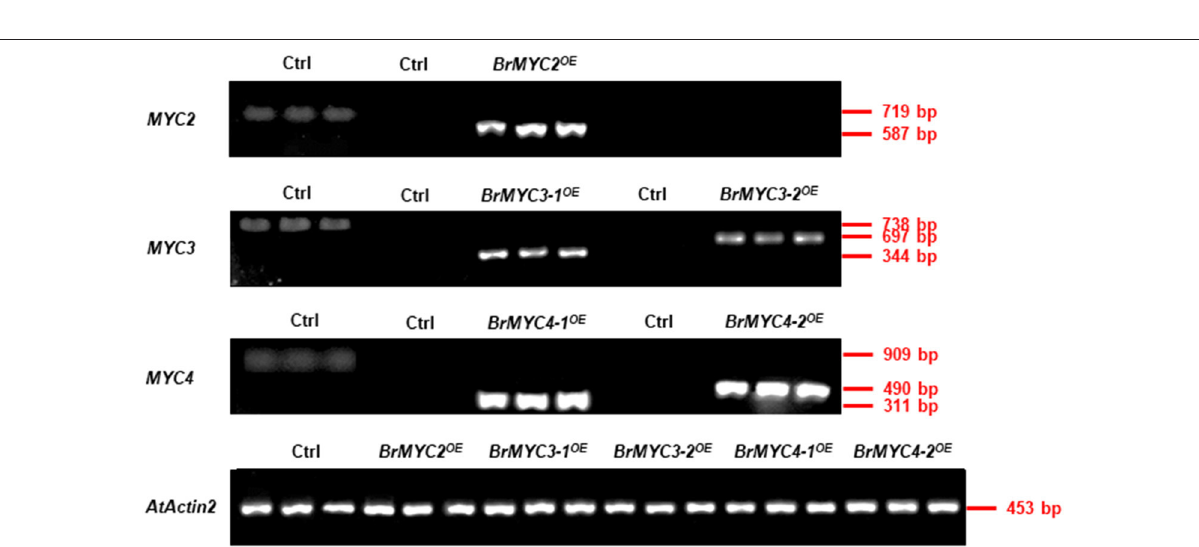
FIGURE 9 | Semi-quantitative RT-PCR analysis of BrMYC2/3/4 genes in 8-day-old transgenic Arabidopsis. The left column of Ctrl with three lanes used primers from corresponding Arabidopsis genes, and the other’s Ctrl used primers from corresponding Brassica rapa genes. AtActin2 serves as an internal